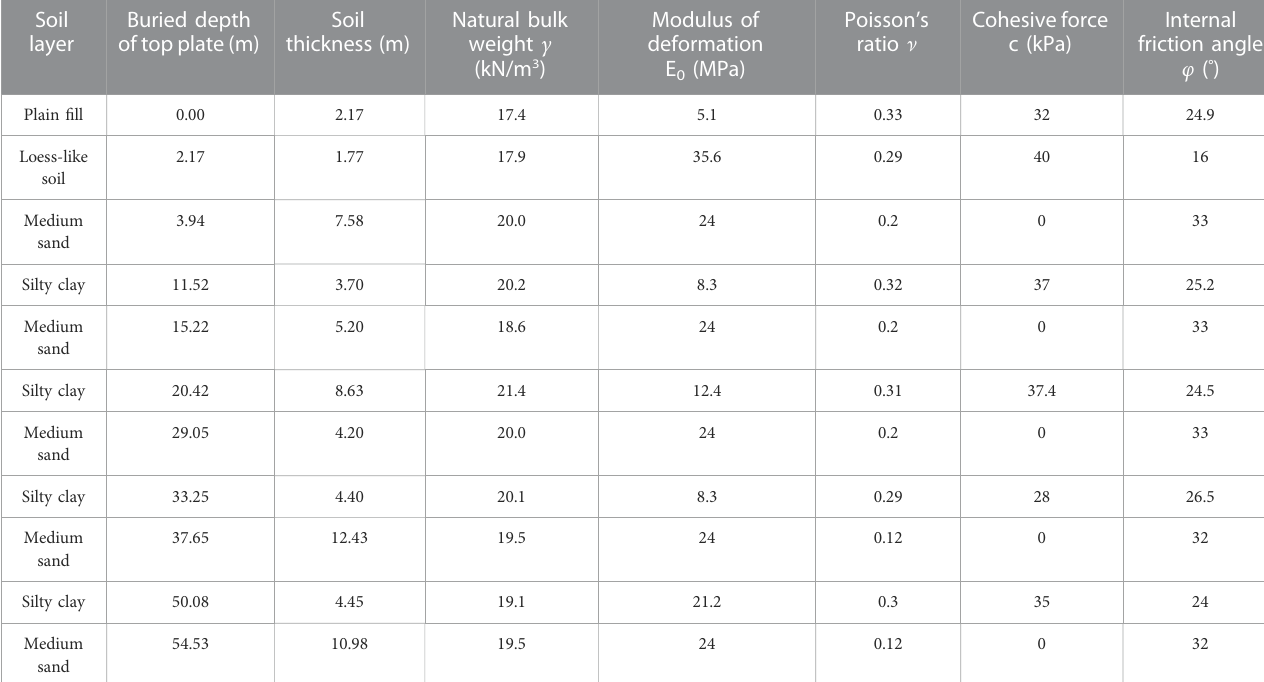
TABLE 3 Soil properties of fi rst-level terrace of Weihe